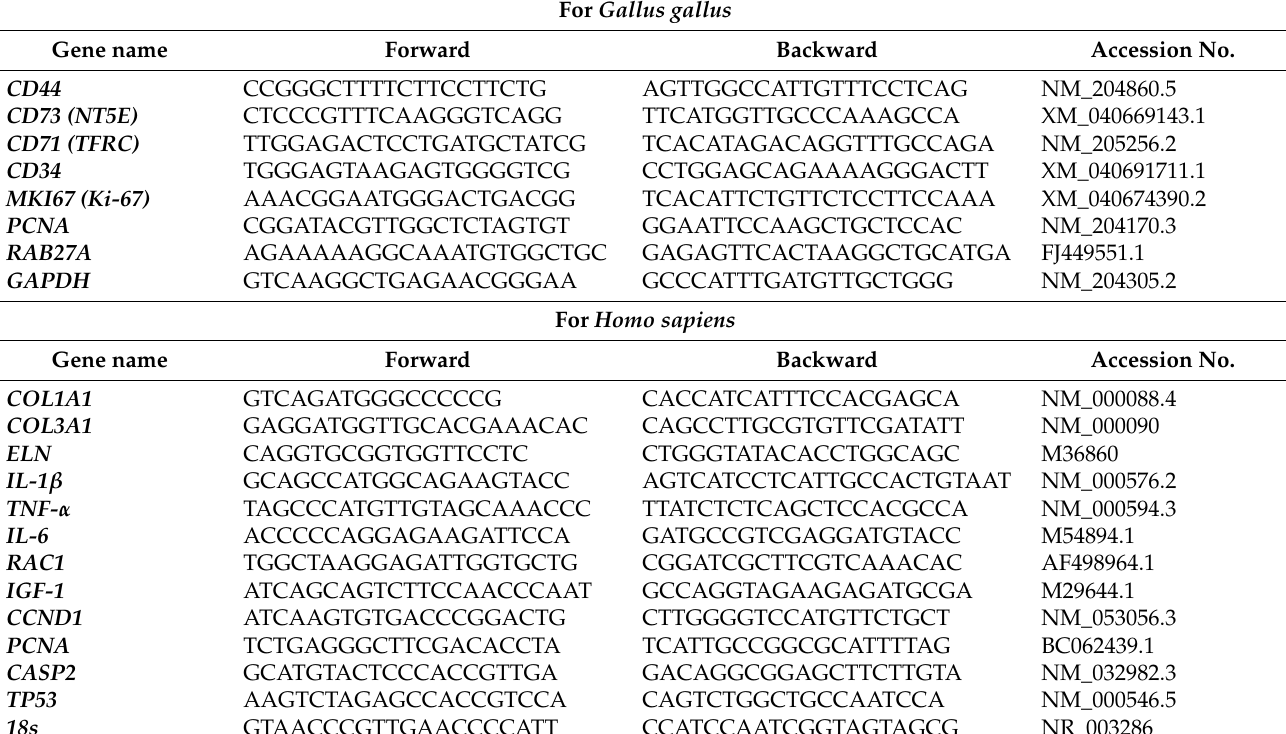
Table 1. The primer sequences used for QPCR